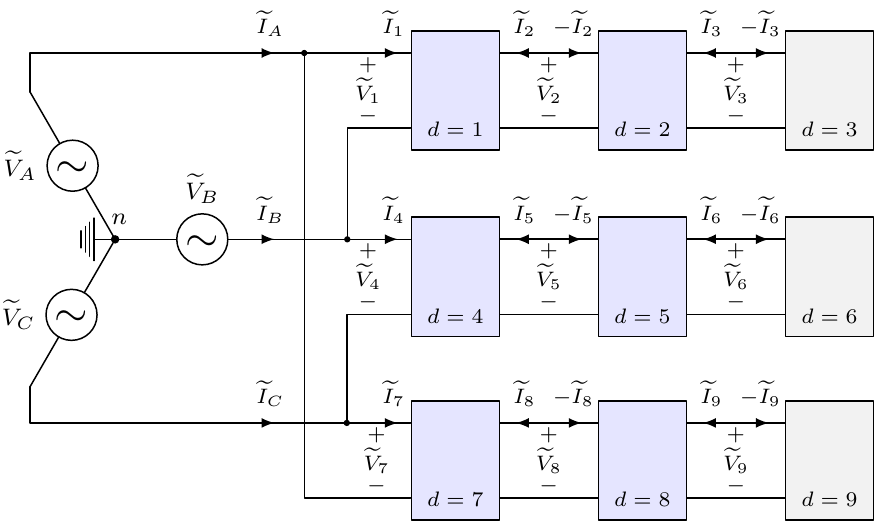
Figure 8. Balanced electrical network with two-port linear transformer